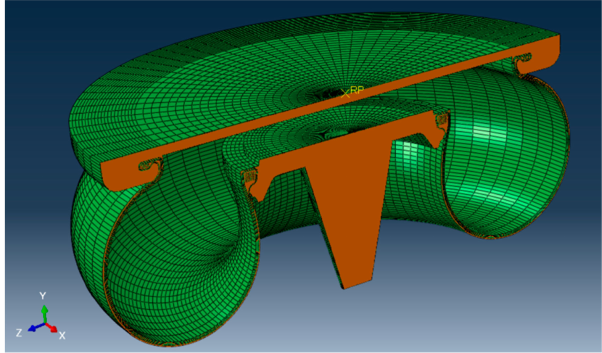
Figure 7. FEM of an air